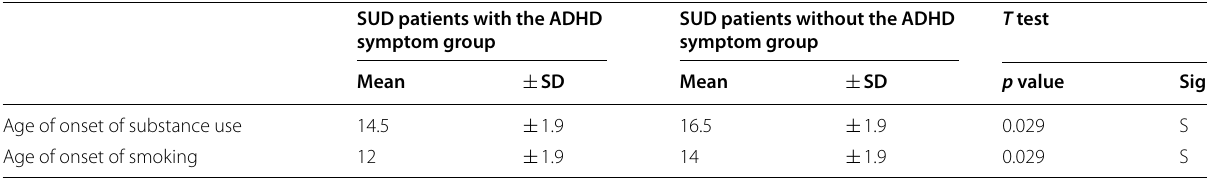
Table 2 Comparison between SUD patients with the ADHD symptom group and SUD patients without the ADHD symptom group as regards age of onset for substance use and smoking SUD patients with the ADHD SUD patients without the ADHD symptom group symptom